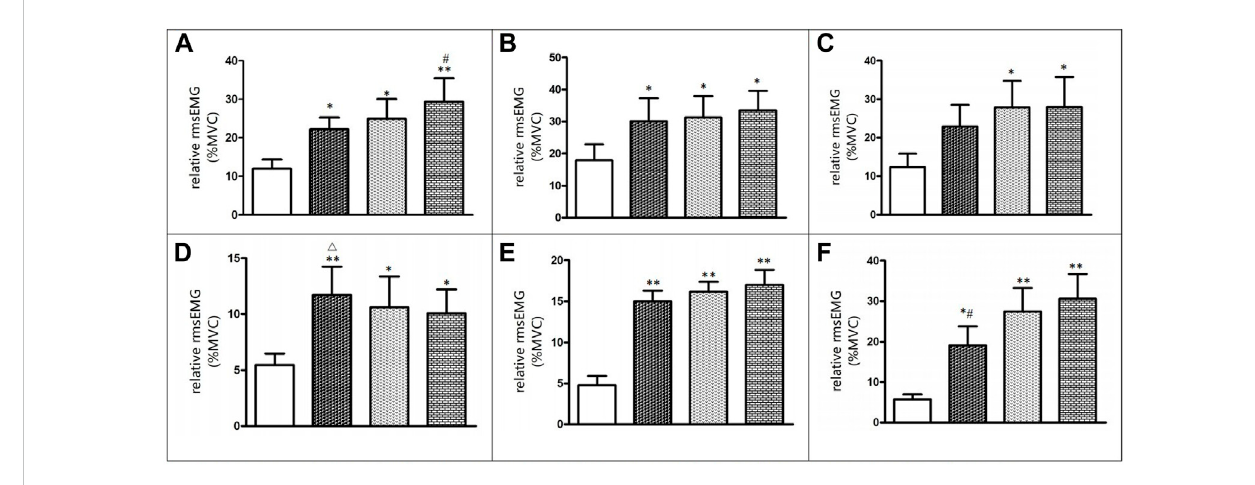
FIGURE 2 Beforeandafter changeinEMGactivitylevel (A) Vastuslaterails (B) VastusMedials (C) Rectusfemoris (D) Tibialisanterior (E) Gastrocnemius medialis (F) Soleus.